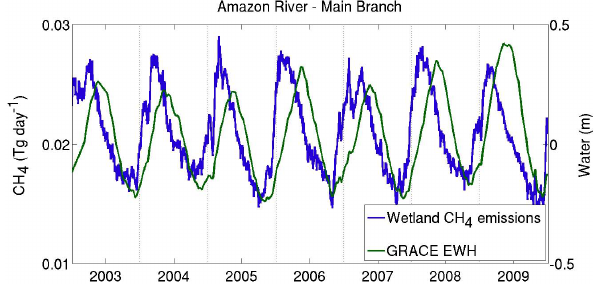
Fig. 3. Daily wetland CH 4 emissions for 2003–2009 (blue) and GRACE equivalent water height (green) over the central branch of the Amazon River (0 ◦ –6 ◦ S, 40 ◦ –80 ◦